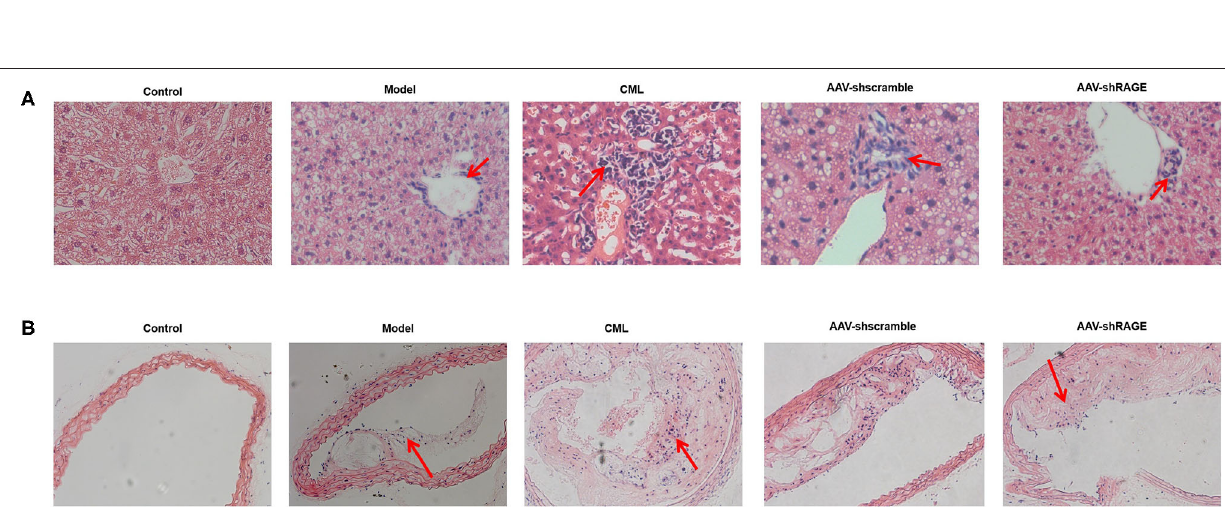
Frontiers in Medicine |